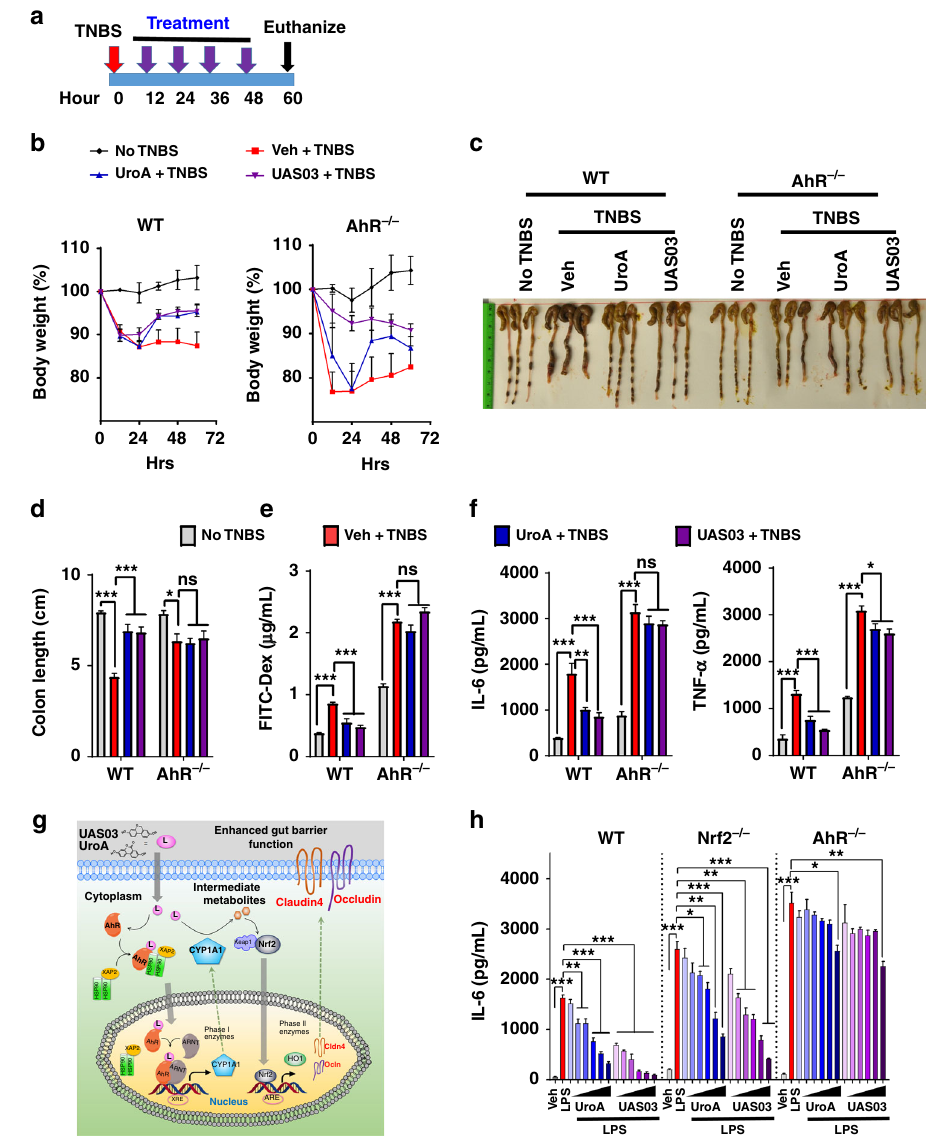
Fig. 8 UroA/UAS03 exert bene fi cial activities through AhR-dependent pathways. a – e Colitis was induced using TNBS in C57BL/6 (WT) and AhR − / − mice ( n = 4/group 7 – 8 week old age). Mice were treated with Veh or UroA/UAS03 (20 mg/kg bodyweight) every 12 h post TNBS administration and mice were euthanized at post 60 h TNBS administration. a TNBS-induced colitis experimental design and treatment regimen. b Percent body weight loss (No TNBS- Solid black line; Veh + TNBS- Solid red line; UroA + TNBS- Solid blue line; UAS03 + TNBS- Solid purple line), c representative colon images, d colon lengths, e gut permeability, f serum levels of IL-6 and TNF- α were determined. Statistical analysis was performed (unpaired t -test) using Graphpad Prism software. Error bars, ± SEM *** p < 0.001; ** p < 0.01; * p < 0.05. g AhR-Nrf2 dependent tight junction protein regulation by UroA/UAS03. UroA/UAS03 (L: ligands) bind to AhR and activate its nuclear translocation to induce expression of Cyp1A1 and Nrf2. Further, UroA/UAS03 causes